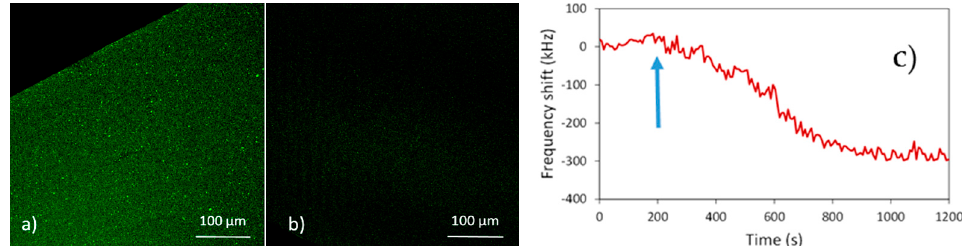
Figure 3. Confocal fluorescence microscopy images of the surface of the graphene-covered SMRs incubated with streptavidin-FITC. ( a ) Positive control; ( b ) negative control; ( c ) time evolution of the frequency when passing polyclonal IgG antibody biotin conjugated on functionalized sensors (starting time indicated by the